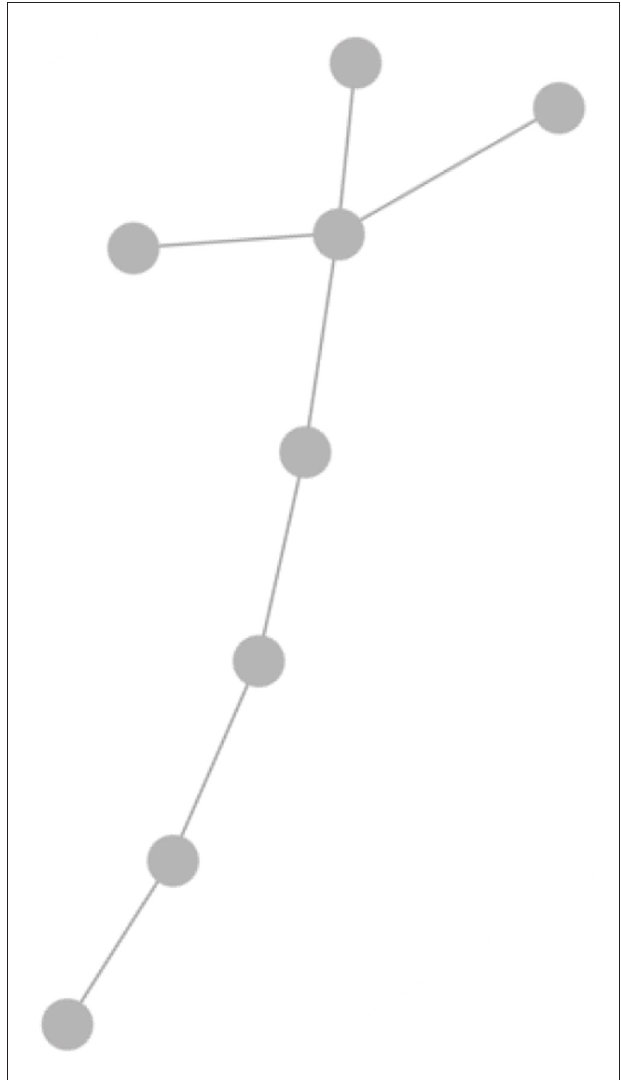
FIGURE 11 | Maximum common subgraph between the two AG models illustrated in Figure 10